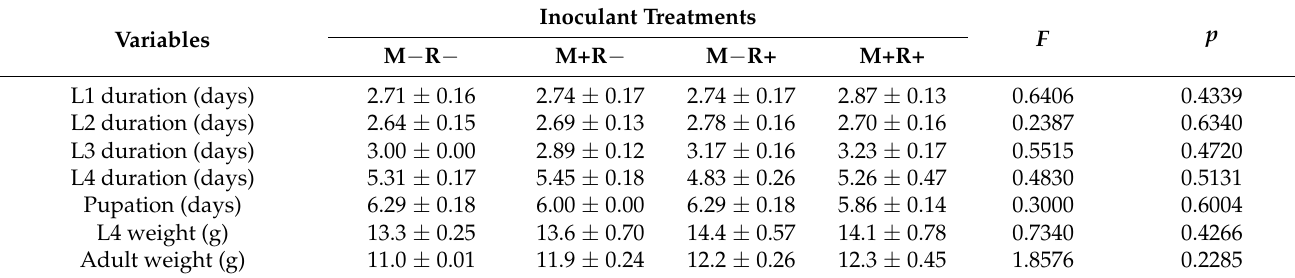
Table 3. The average number of ladybeetles four larval stages and pupation duration, the weight of the fourth larval and adult (mean ± SE, F, p values, N = 8) of 8 replicates per treatment. Control: M − R − ; Mycorrhizae+Rhizobium: M+R+; Mycorrhizae: M+R − ; Rhizobium: M − R+. Linear mixed effect model (LMM) follow by ANOVA was applied, and no measurable difference was observed between the inoculant treatments following the